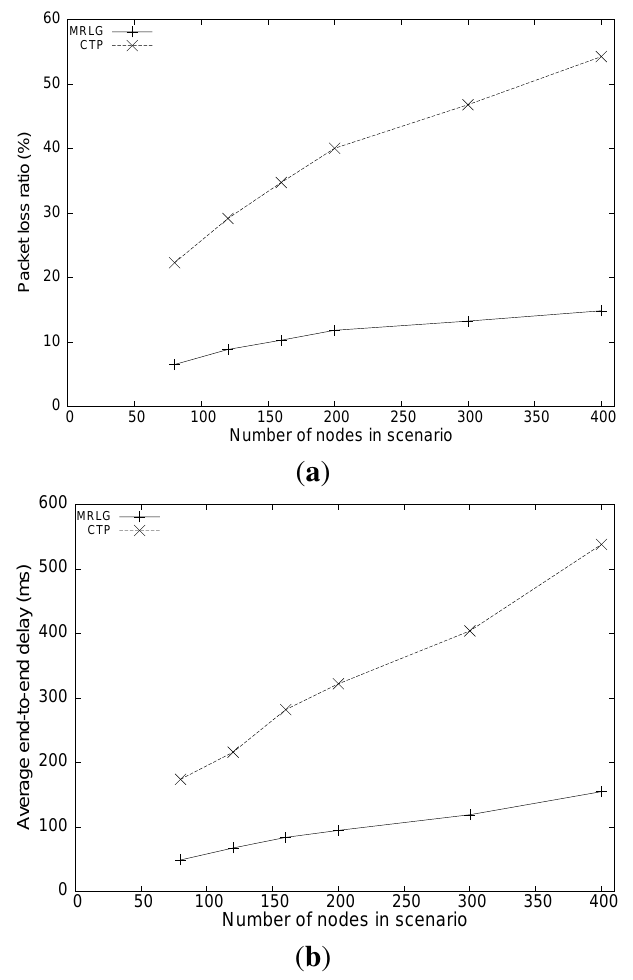
Figure 10. Varying the number of nodes per scenario: ( a ) packet loss ratio, ( b ) end-to-end